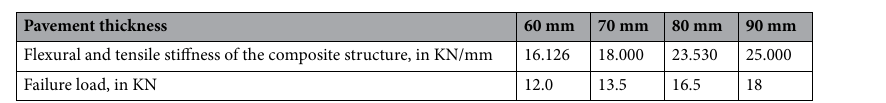
Table 4. Flexural and tensile stiffness and failure load of the composite structure formed by different thicknesses of single-layer pavement under the action of a negative bending moment.